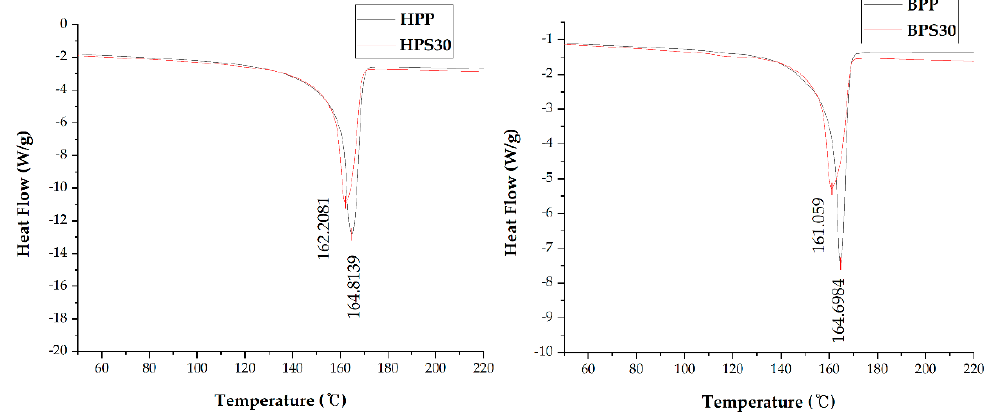
Figure 5. Heating curve of DSC results.